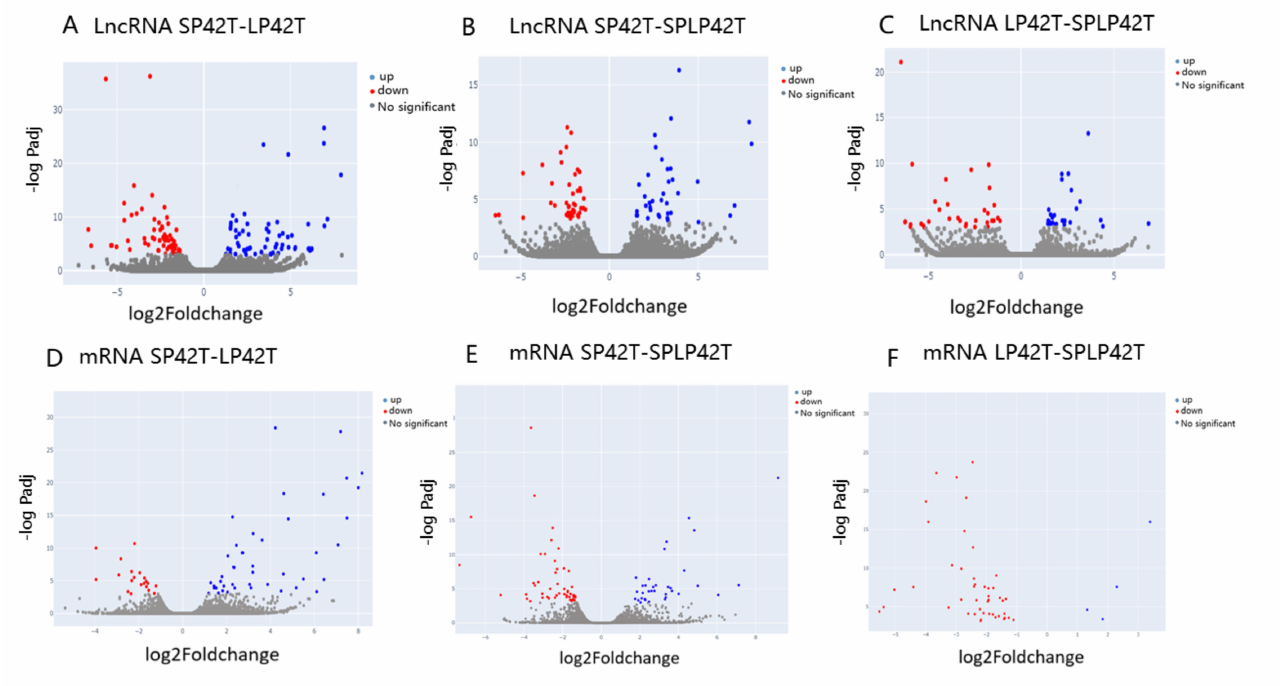
Figure 2. Analysis of differentially expressed transcripts. ( A ) Differentially expressed transcripts were assessed based on a volcano map of the DE-lncRNAs in SP42 and LP42. ( B ) Differentially expressed transcripts were assessed based on a volcano map of the DE-lncRNAs in SP42 and SPLP42. ( C ) Differentially expressed transcripts were assessed based on a volcano map of the DE-lncRNAs in LP42 and SPLP42. ( D ) Differentially expressed transcripts were assessed based on a volcano map of the DE-mRNAs in SP42 and LP42. ( E ) Differentially expressed transcripts were assessed based on a volcano map of the DE-mRNAs in SP42 and SPLP42. ( F ) Differentially expressed transcripts were assessed based on a volcano map of the DE-mRNAs in LP42 and SPLP42. Blue and red represent up-regulated and down-regulated transcripts, respectively (Table